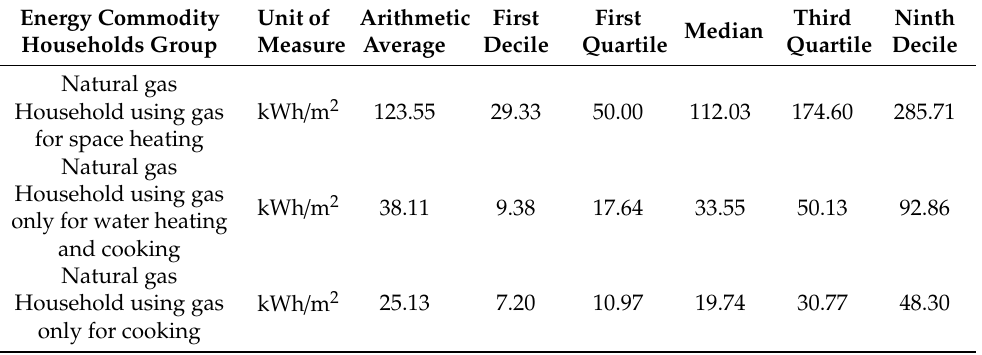
Figure 6. Distribution of natural gas consumption in households in Poland together with a comparison for the analyzed building (characteristic p. 2.2) Source: own study based on [1]. Table 1. Demand for heat and gas consumption for heating purposes in households. Source: own study based on